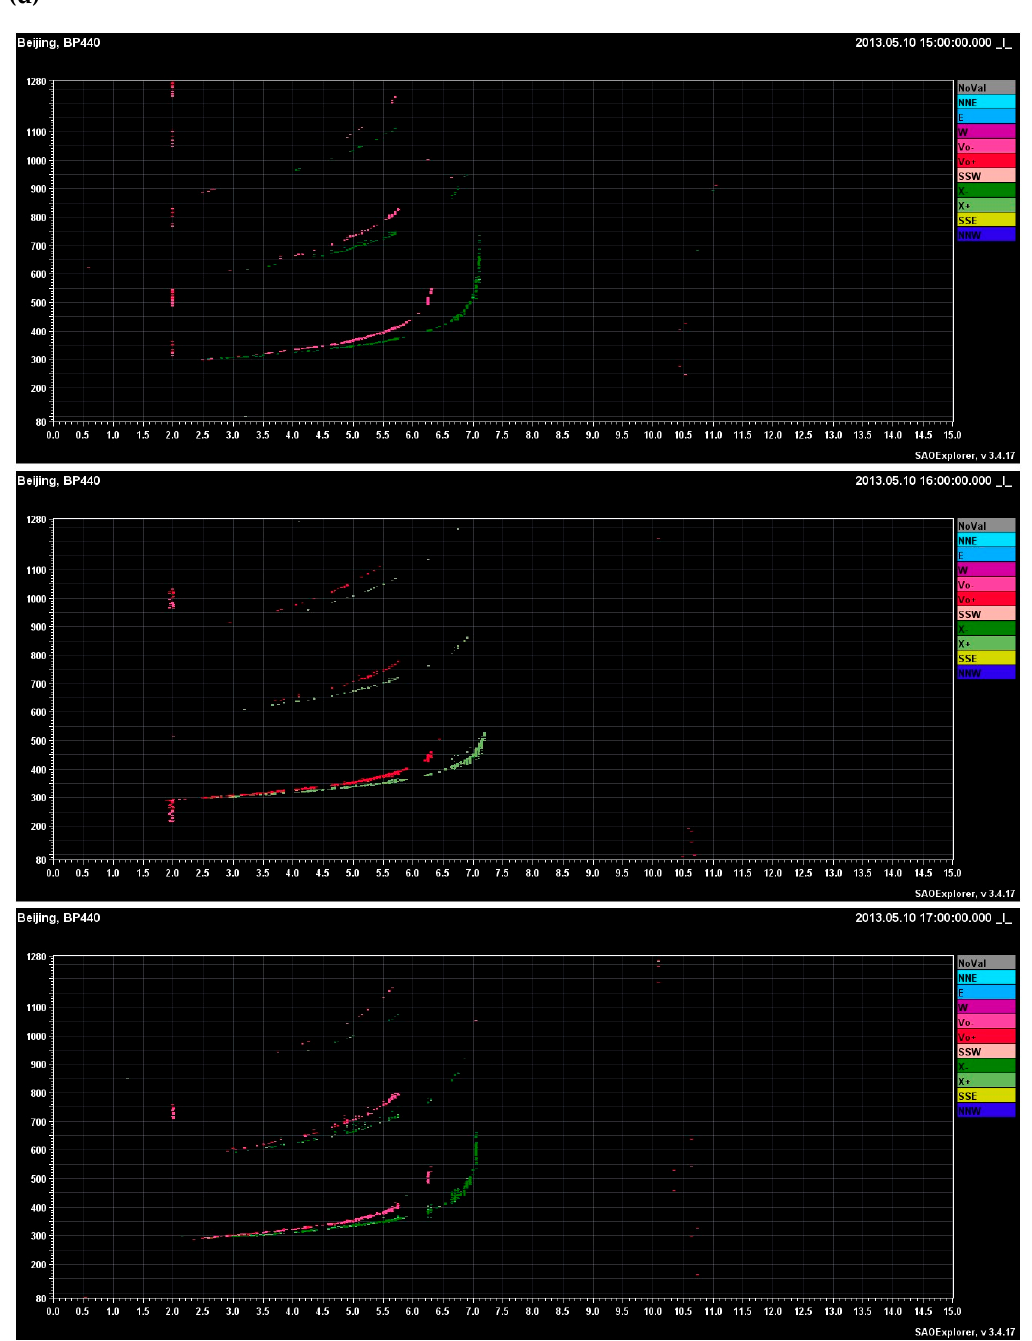
Figure 8. ( a , c,d ) The evolution of sodium densities and ionogram on 10 May 2013. ( b ) Temperature profiles before the LTSLs, with an extremely low temperature of 140 K at 103 km at 17:36 LT (LT = UT + 8) on 10 May